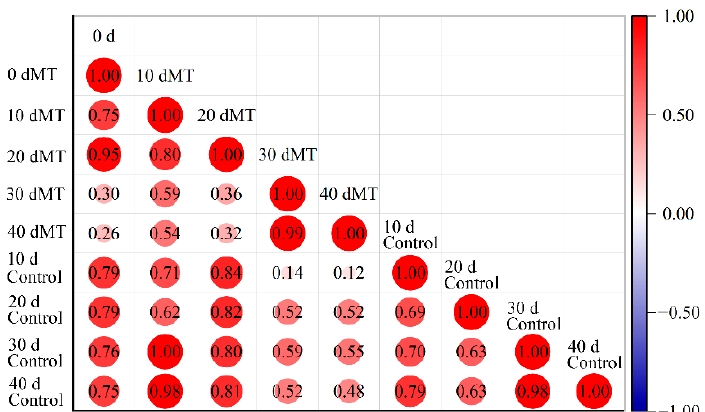
Figure 3. Melatonin affects the correlation of cuticular wax.